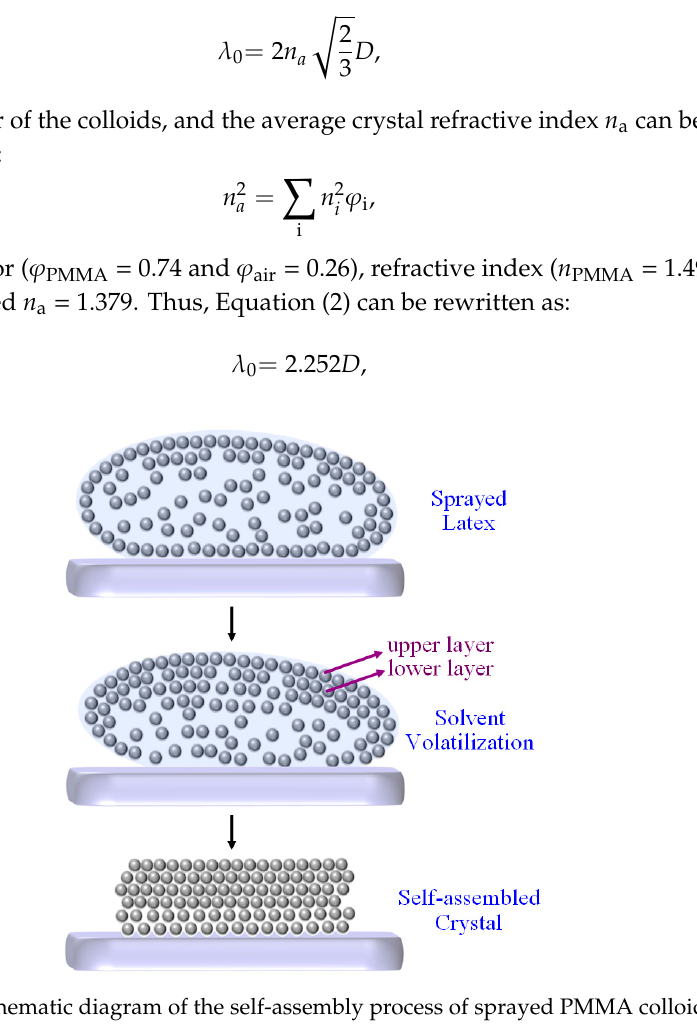
Figure 3. Schematic diagram of the self-assembly process of sprayed PMMA colloids.